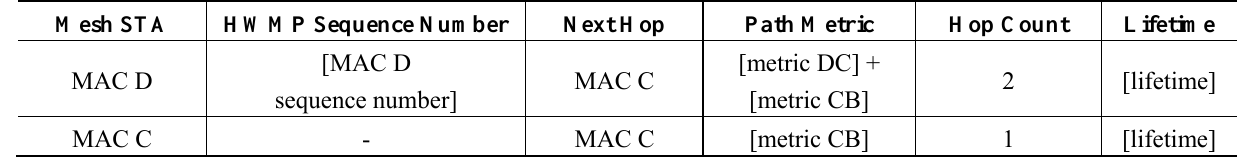
Table 2. Routing table for mesh STA